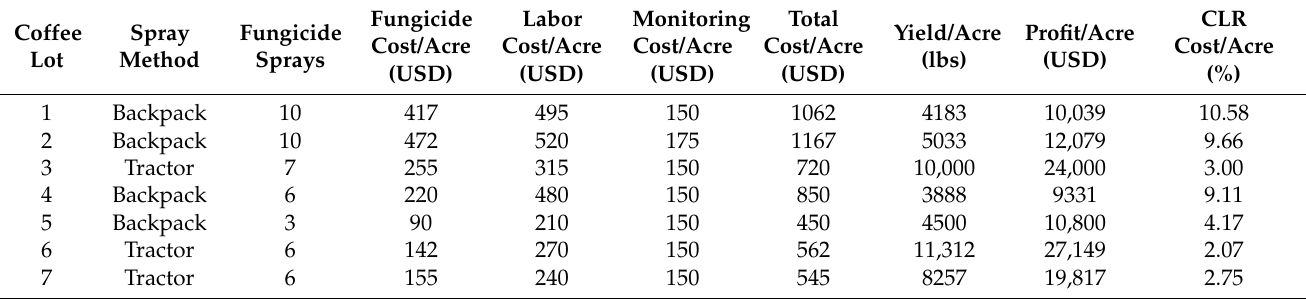
Table 2. Information used to calculate costs to manage CLR during the 2021 season for seven commercial coffee lots on Hawaii Island. Total cost to manage CLR per acre was based on the number of fungicide sprays and the combined cost of products (excludes cost of B. bassiana used for CBB management), labor (backpack sprayer: USD 15–20/h, tractor sprayer: USD 40/h) and monitoring (USD 25/survey). Estimates for profit/acre (USD) were based on yield/acre (lbs) and a market value of USD 2.40/lb for coffee cherry. The final cost was estimated as the percentage of total profits per acre spent to manage